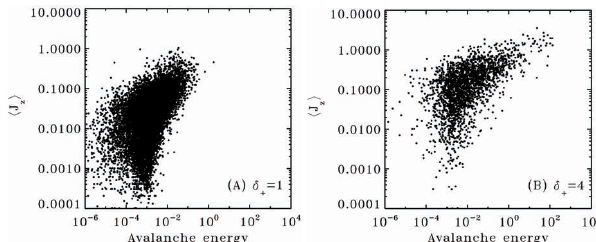
Fig. 6. Correlation relation between the avalanche energy and dif- ferential in mean electrical current < J z > for two different values of the perturbation amplitude ( δ + ). In panel (A) we show the result obtained for δ + =1 characterized by a Pearson correlation coeffi- cient of 0.33 while in panel (B) we show the corresponding results for δ + =4 where correlation coefficient is